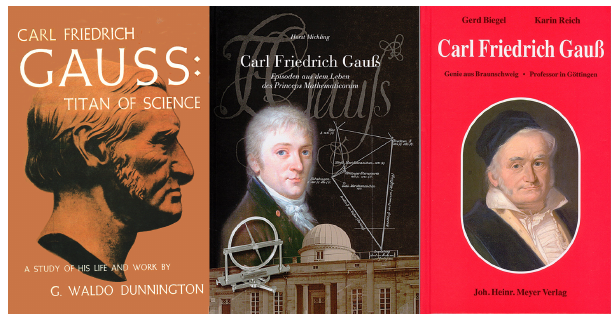
Figure 4. Some of the biographies of Carl Friedrich Gauss pub- lished by members of the Gauss Society. From left: Dunning- ton (1955), Michling (1976), and Biegel and Reich (2005).